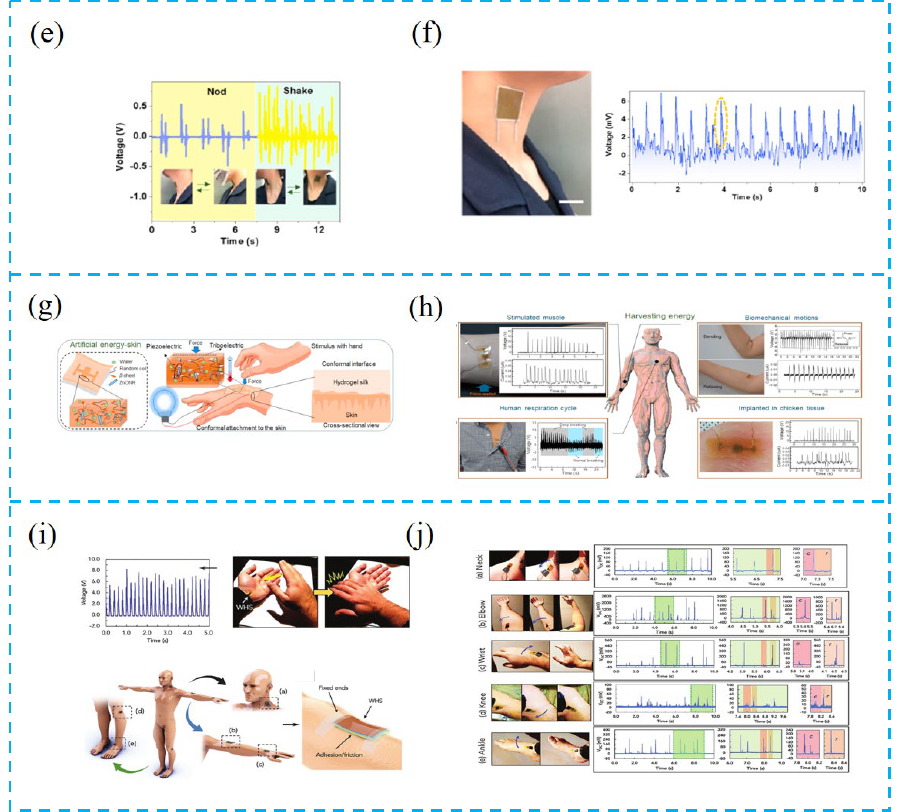
Figure 8. ( a ) Response to different types of mask vibrations for two different testers. ( b ) PTHS output voltage, with various facial movements of the test subject. ( c ) ( 1 ) Three-dimensional (3D) illustration and real photo of the applicability of the hybrid PENG underneath the surgical face mask. ( 2 ) Concept of the motional energy sources harvested by the hybrid PENG. ( d ) ( 3 ) Open-circuit voltage signals generated by the hybrid PENG for specific movements reproduced at ∼ 1 to 1.5 Hz: ( i ) smiling, ( ii ) mouth-opening, ( iii ) adjusting the mask, and ( iv ) normal breathing in/out. ( e ) The voltage signals of head movements. ( f ) Photograph demonstrating the E-skin as a wearable self-powered pulse monitoring sensor. ( g ) Schematic illustration to show the concept and working principle of artificial EG-skin using silk hydrogel. ( h ) Forearm by tapping the hand to stimulate the muscle, elbow by bending and releasing, chest for monitoring respiration cycles, and embedded in chicken breast tissue. ( i ) Open-circuit voltage of the HS under hand tapping frequency of ~5 Hz and force of ~5 N on the WHS applied on the human wrist (as in the photos), and 3D representation of the human body and the positions of the WHS for sensing human gestures. ( j ) Open-circuit voltage of the WHS for monitoring movements of ( a ) neck, ( b ) elbow, ( c ) wrist, ( d ) knee, and ( e )